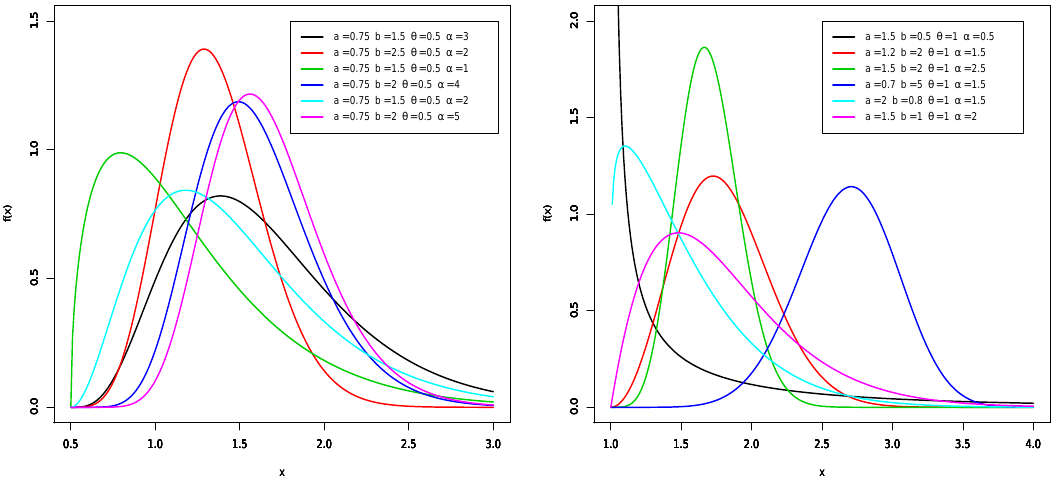
Fig. 1. pdf of EWP distribution for selected values of the